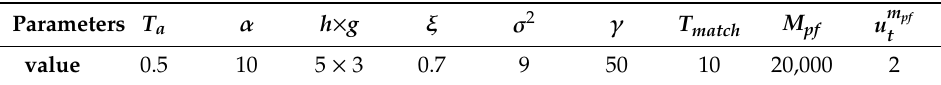
Table 3. Selected Values for the Defined